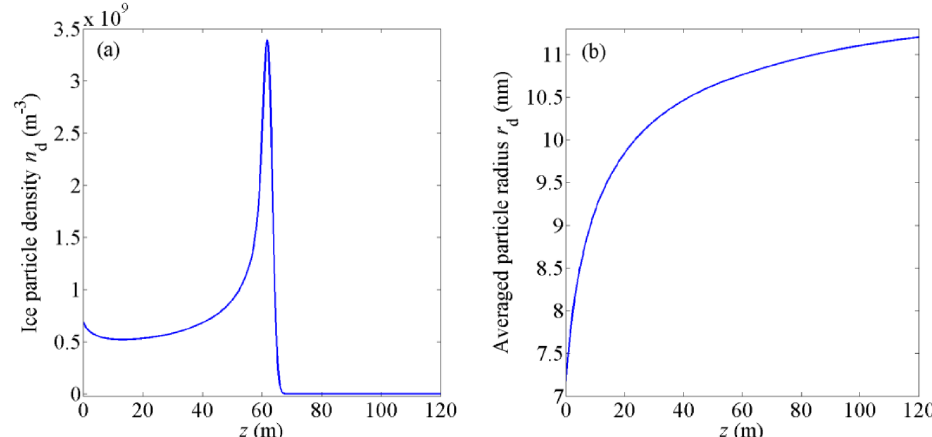
Figure 2. Distribution of (a) ice particle density and (b) averaged particle radius near the lower boundary of the condensation